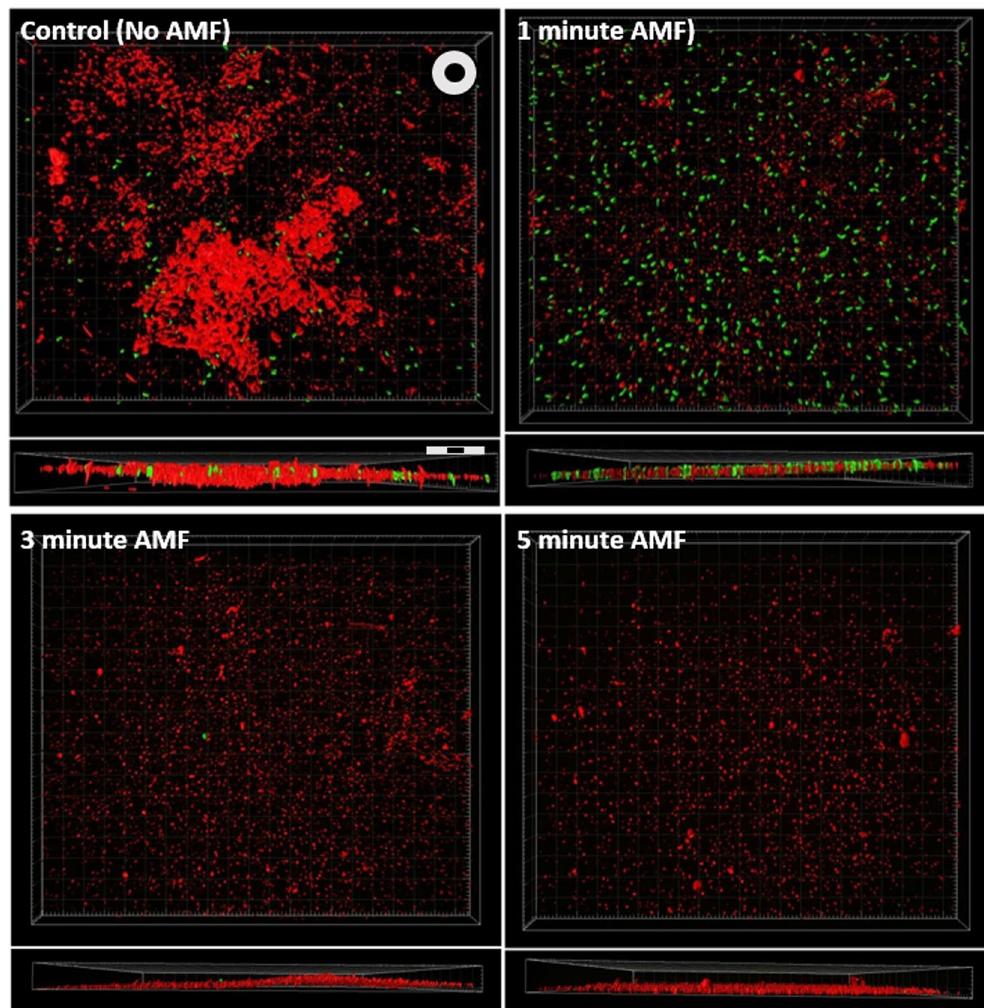
Figure 5. Confocal microscopy of GFP expressing P aeruginosa biofilm on a metal washer support SEM findings that AMF initially targets EPS. Confocal microscopy images of infected washers exposed to AMF show a decrease in the biofilm matrix (red) and number of bacteria (green) as the duration of an AMF exposure was increased. For exposures greater than 3 minutes it was difficult to detect any bacteria on the washer surface. At 1 minute, the number of bacteria appear relatively unaffected, but the biofilm matrix signal is greatly decreased, suggesting heating initially affects this matrix. The washers were incubated in GFP-PA01 for 18 hours to form a biofilm. The scale bars in each panel indicate 20 μ